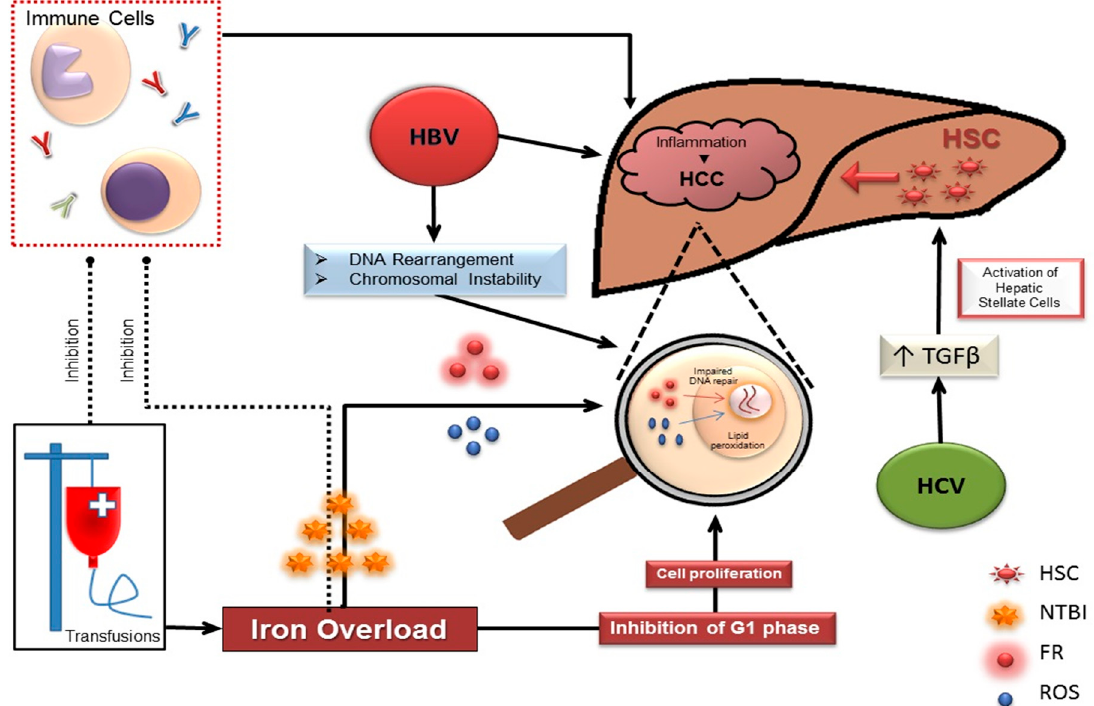
Figure 1. Different mechanism related to HCC development in thalassemia patients. FR: Free Radicals; HBV: Hepatitis B Virus; HCV: Hepatitis C Virus; HCC: Hepatocellular carcinoma; HSC: Hepatic Stellate Cells; NTBI: Non-Transferrin Bound Iron; ROS: Reactive Oxygen Species; TGF β : Transforming Growth Factor β .